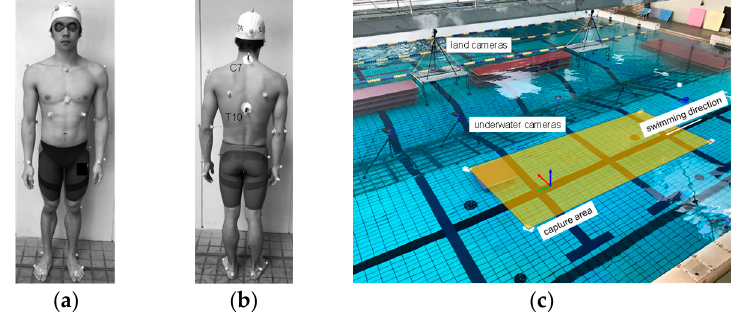
Figure 1. Experimental setup. ( a ) Front view and ( b ) back view of a participant with attachment of the markers; ( c ) motion-capture camera